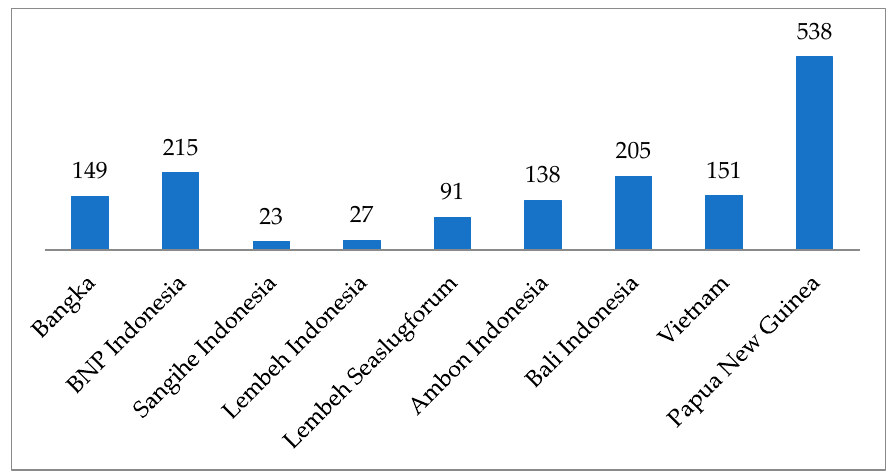
Figure 28. Species diversity from Bangka Archipelago compared with other studies in Indonesia and areas nearby. Data taken from the following literature: BNP, Indonesia [15,16]; Sangihe, Indonesia [18]; Lembeh Island, Indonesia [17,21]; Ambon, Indonesia [3–6]; Bali, Indonesia [39]; Vietnam [22]; and Papua New Guinea [48]. Table 1. Information about collection sites and dates in 2017–2018. *Batu Tiga is the only locality where no samples were collected, and specimens were recorded only by photo-documentation provided by Gianni Valenti.